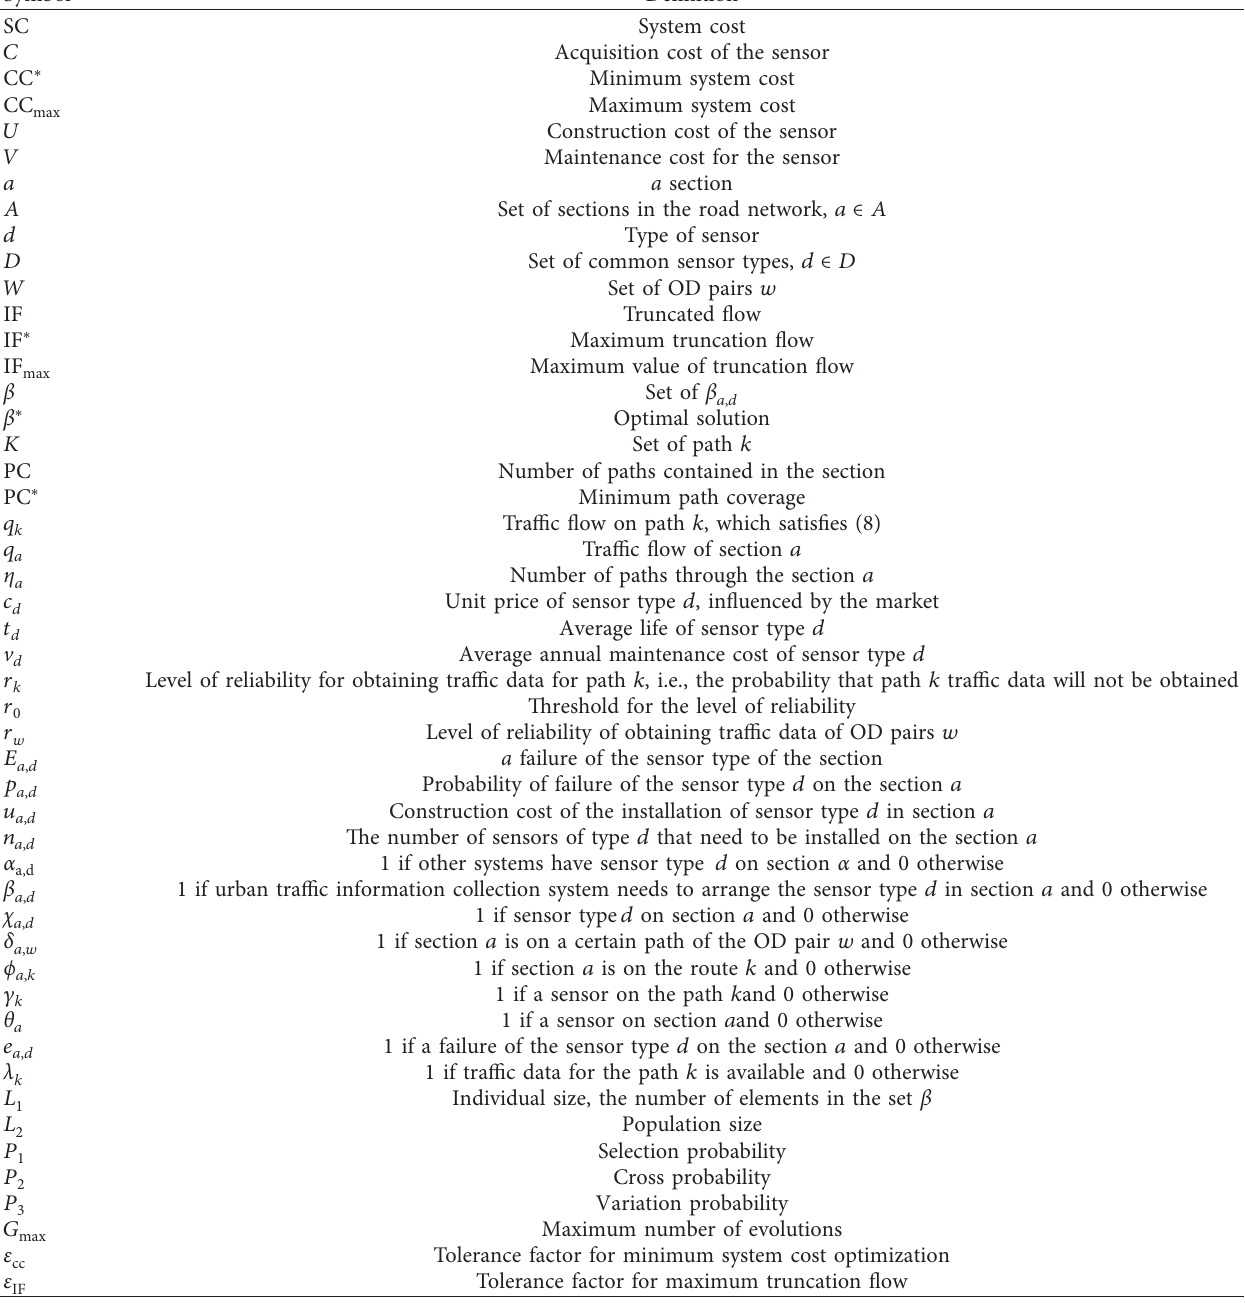
Table 1: Notation